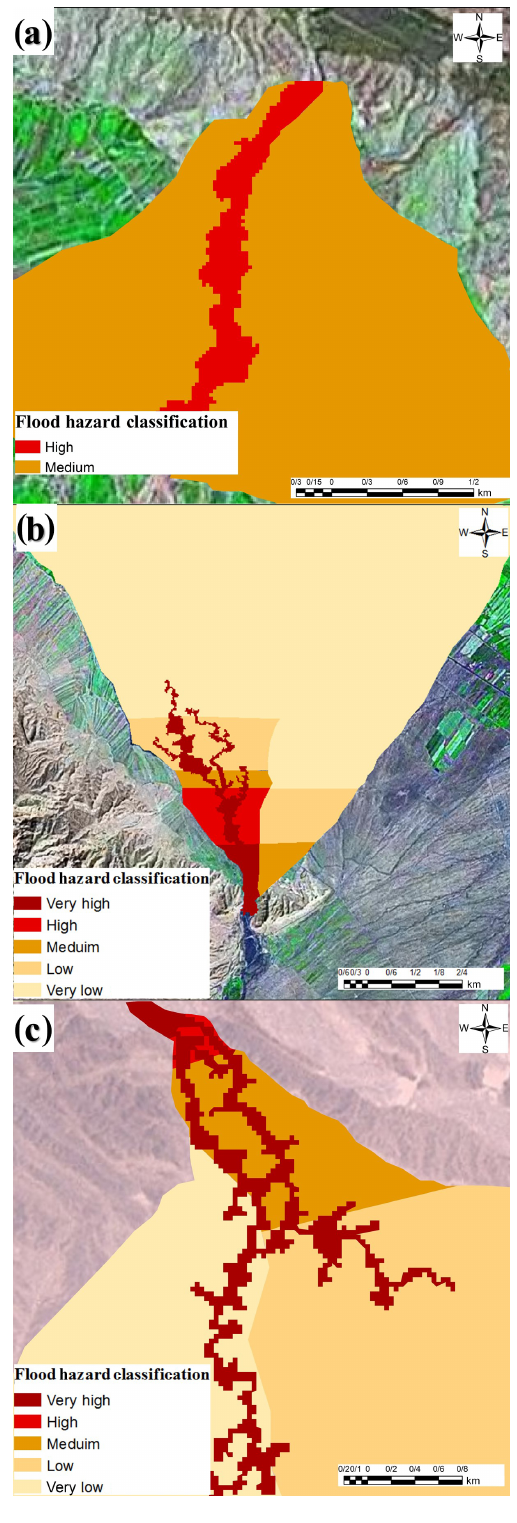
Figure 10. The final integrated results of the FAN model, the FLO- 2D model and the geomorphological approach for the (a) Ferizy, (b) Ardak, and (c) Sarbaz